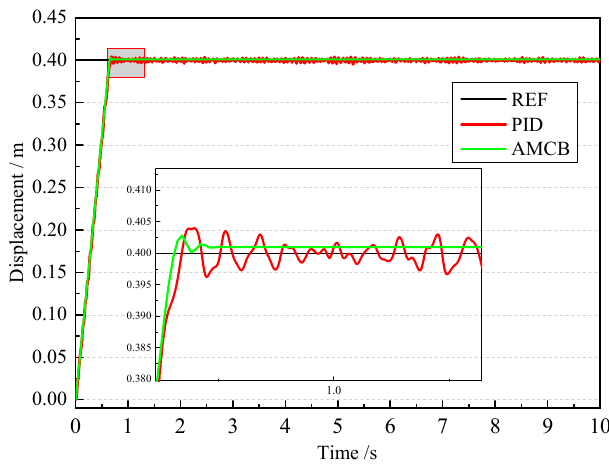
Figure 9. Step response displacement curves of hydraulic cylinder.